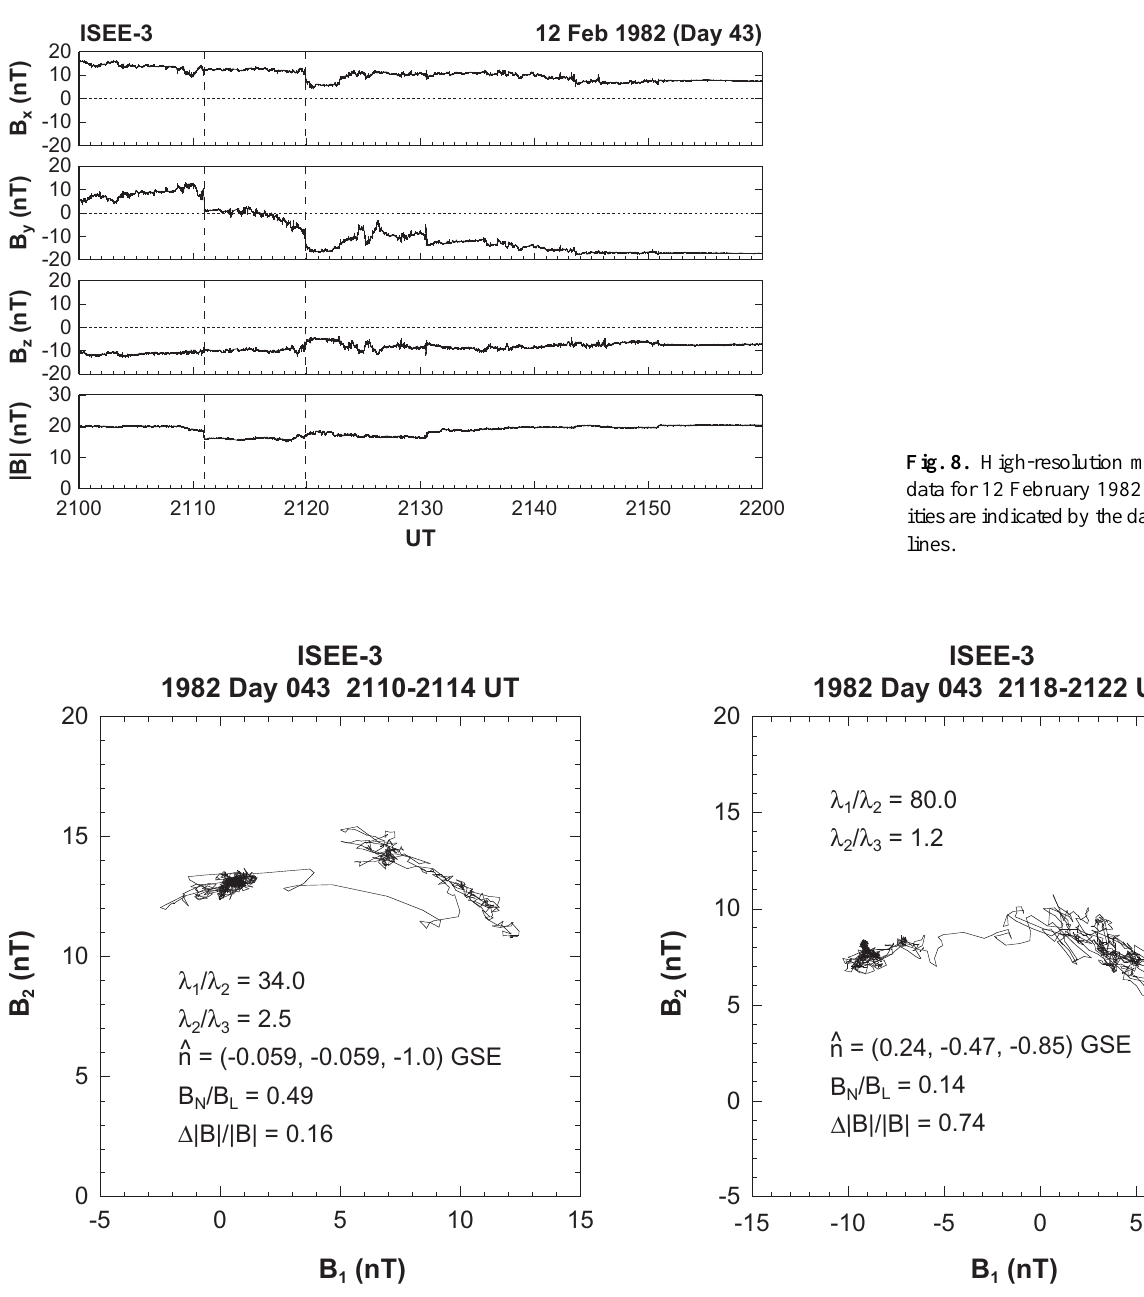
Fig. 9. Minimum variance analysis results for the first discontinuity of Fig. 8. This hodogram displays the field variation in the maxi- mum variance ( B 1 )-intermediate variance ( B 2 ) plane.